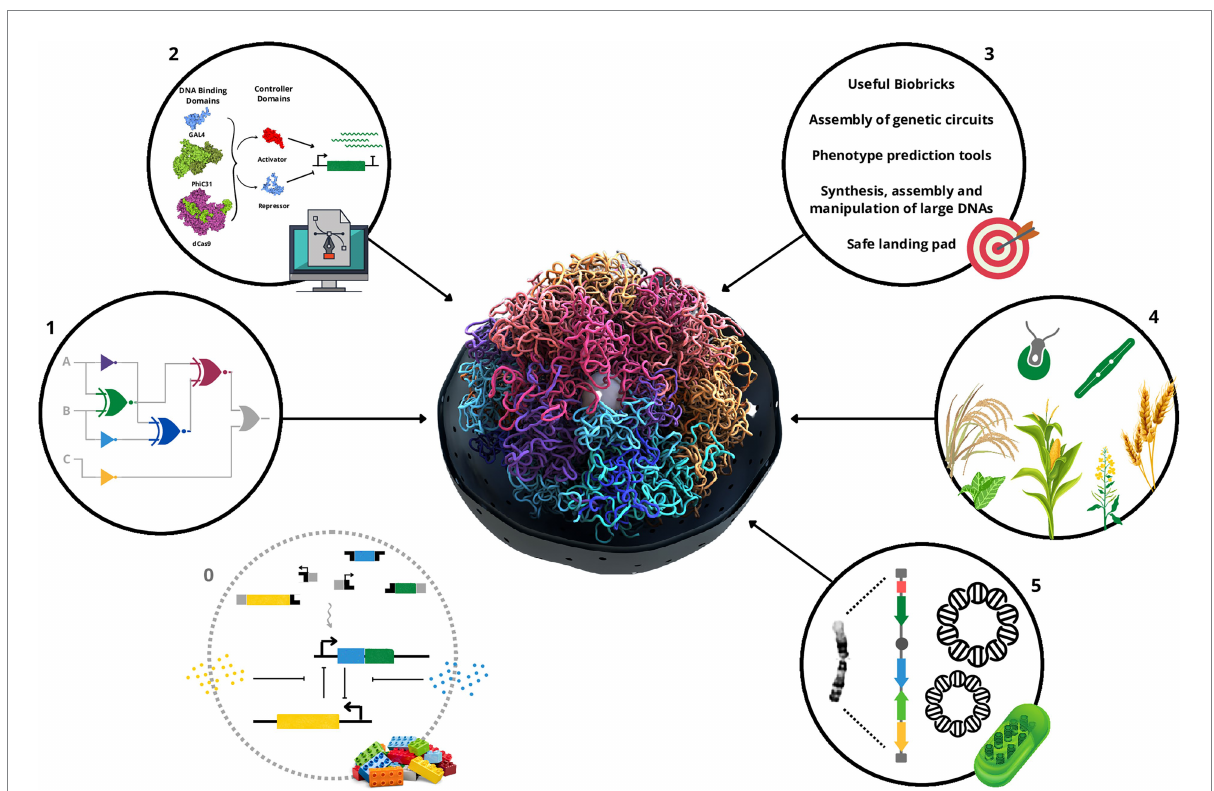
FIGURE 1 Schematic summary of the important steps, challenges, achievements, and prospective usage in synthetic chromosomes for the biocircuits in plants and algae. First, a repository of reliable, functional, orthogonal, scalable biological parts (0) is essential to the assembly of biocircuits (1). Also, tools that allow fine control of the expression of genes that compose the biocircuits with computational methods that can use the biological parts to assemble genetic circuits and predict the phenotype from the genotype are very welcome (2). Those together with the need of a repository for usable biological parts, tools that allow synthesis, assembly and manipulation of large DNAs, and safe harbors for the genetic circuits represent the main challenges in this area (3). Nevertheless, high vitamin A Golden crops, biosensors, and trans-kingdom genetic circuit plants, in addition to biofabric algae have been developed (4). As a perspective, biocircuits could greatly contribute to the control of gene expression once artificial/ synthetic chromosomes become the landing platform for plants and algae development with improved or new functions (5). The 3D design of the molecules in the number 2 scheme was generated by Illustrate (Goodsell et al.,